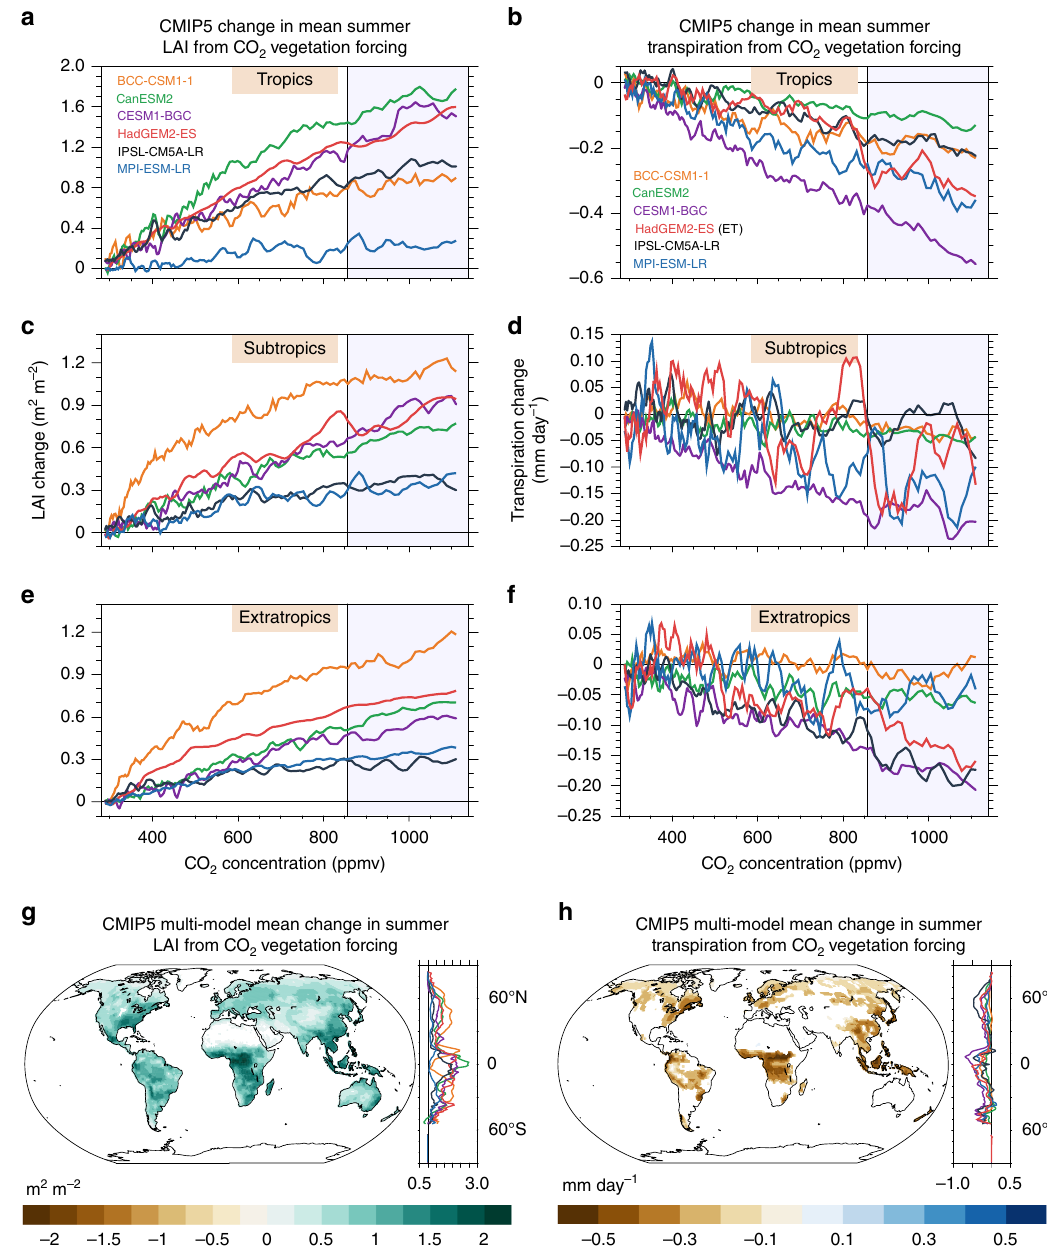
Fig. 1 Change in leaf area index and transpiration from CO 2 vegetation forcing. Change in mean summer a , c , e leaf area index (LAI) and b , d , f transpiration from CO 2 vegetation forcing. For each CO 2 concentration, the area-weighted value for the a – b tropics (15°S – 15°N), c – d subtropics (15°S/N – 30°S/N), and e – f extratropics (30°S/N – 70°S/N) is calculated for the TotalCO2 and RadCO2 simulations. Then, the values are smoothed with a fi ve-year running mean and the difference ( TotalCO2 – RadCO2 ) for each model is plotted. Multi-model mean change in summer g LAI and h transpiration from CO 2 vegetation forcing averaged over the fi nal 30 years of the simulations (shaded region in a – f ). Only statistically signi fi cant changes are plotted (Methods). Zonal averages of LAI and transpiration change (land grid points) for each model are plotted to right of each map. June – September (December – March) values are used in the Northern (Southern) Hemisphere. Evapotranspiration (ET) is used for HadGEM2-ES in b , d ,